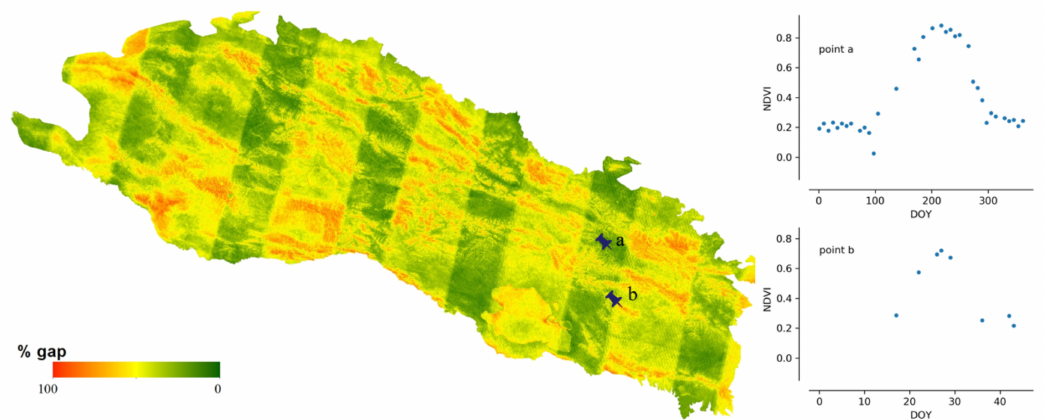
Figure 6. The fraction of gaps in composited Landsat 8-day NDVI time series from 2015 in the Qilian Mountain range region.